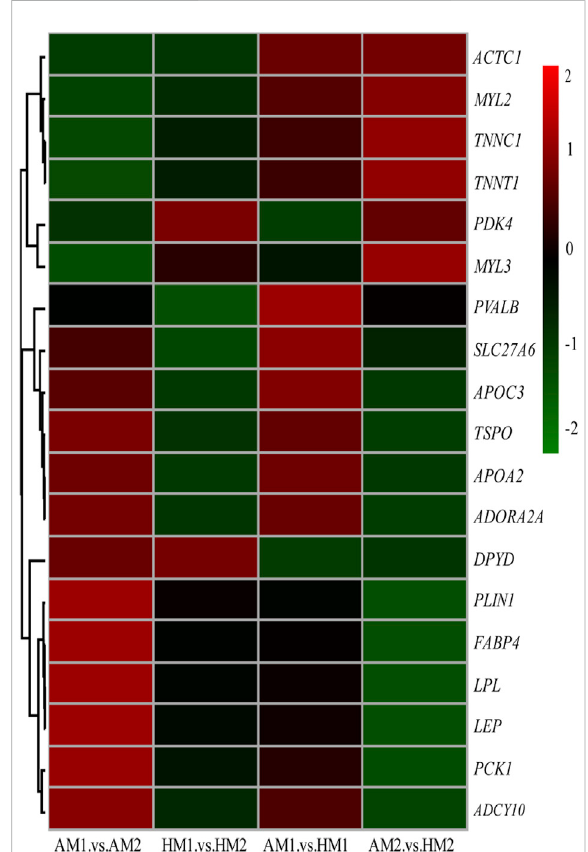
FIGURE 3 TheheatmapofcandidategenesinmuscletissueofAltayand Hu lambs. AM1 vs AM2: muscle tissue of Altay lambs at − 5 ° C compared with lambs at 20 ° C; HM1 vs HM2: muscle tissue of Hu lambs − 5 ° C compared with at 20 ° C; AM1 vs HM1: muscle tissue of Altay lambs at − 5 ° C compared with Hu lambs at -5 °